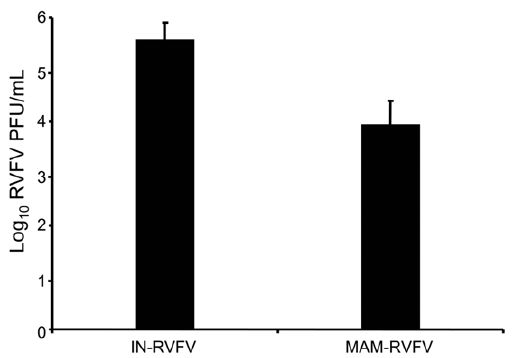
Figure 3. Exvivo infection of peripheral blood mononuclear cells (PBMCs) in RVFV-infected goats. PBMCs isolated from goat blood at indicated time points post RVFV infection were stained for intracellular expression of RVFV non structural protein NSm1 and infected cells identified by flow cytometry. Means of RVFV + PBMCs from IN-RVFV-infected goats are represented by the open histograms and MAM-RVFV infected goats by the filled histograms. Error bars represent standard deviation of means (n=3 goats each).